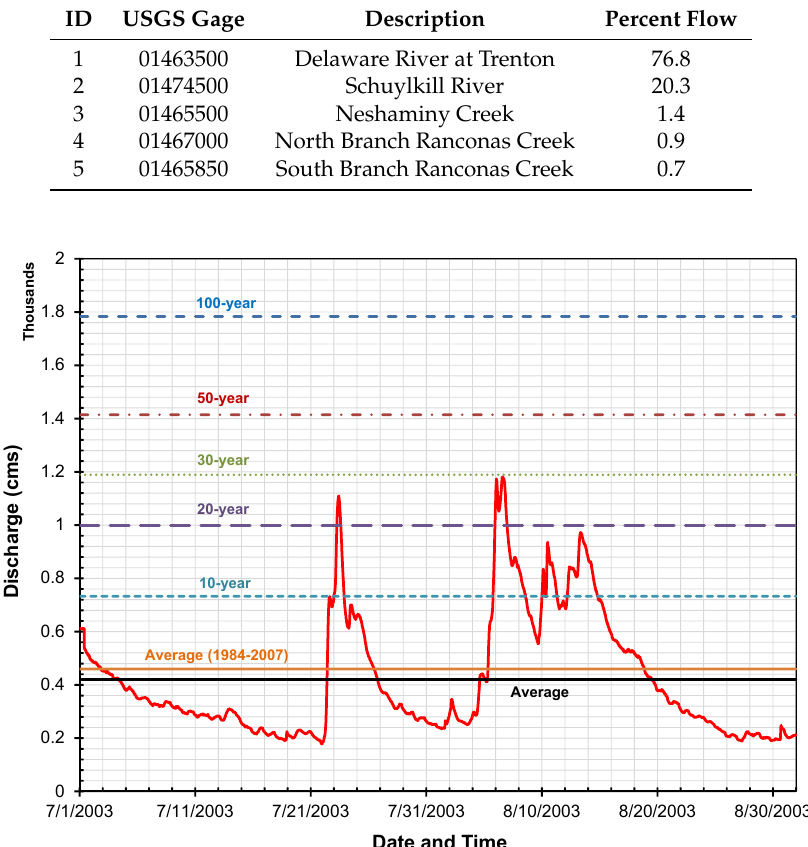
Figure 5. Total freshwater discharge at the inland boundary of the overall domain at Commodore Barry Bridge.